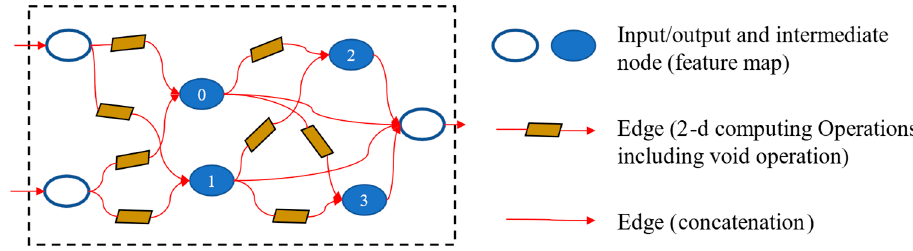
Figure 7. Cell architecture (the number 0-3 means the order of the intermediate